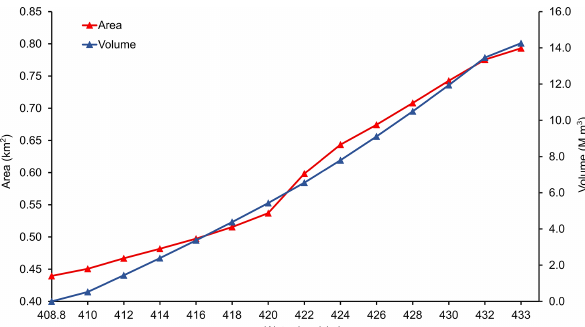
Figure 2. Lake area (km 2 ) and lake volume (Mm 3 ) with changing water level (m), calculated for every second metre, based on the 2021 post-drainage DEM. The lake has a maximum water level of 433m, after which it overspills the damming glacier. The sharp in- crease in lake area from ∼ 420 to 422m is due to a plateau at the northeastern part of the lake (Fig. A1).